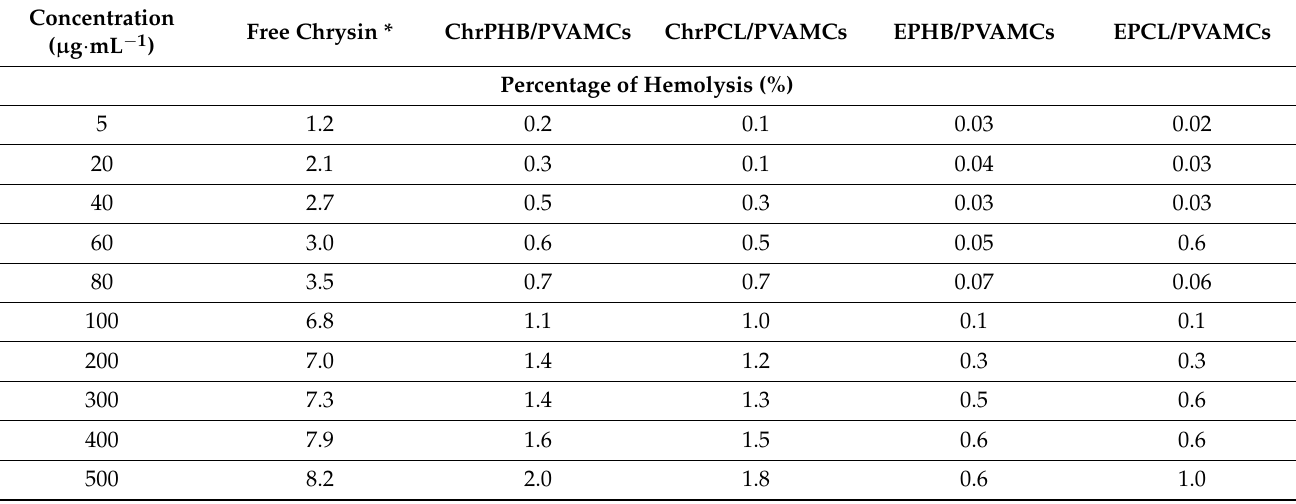
Table 3. Concentration-dependent hemolytic activity of free chrysin, ChrPHB/PVAMCs, ChrPCL/PVAMCs, EPHB/PVAMCs, and EPCL/PVAMCs.